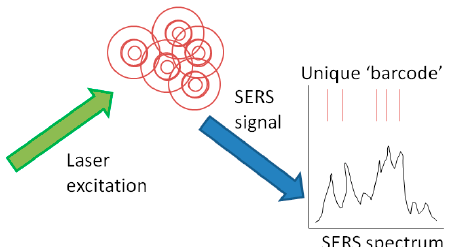
Figure 9. Laser excitation of SANAs to provide a spectroscopic barcode.